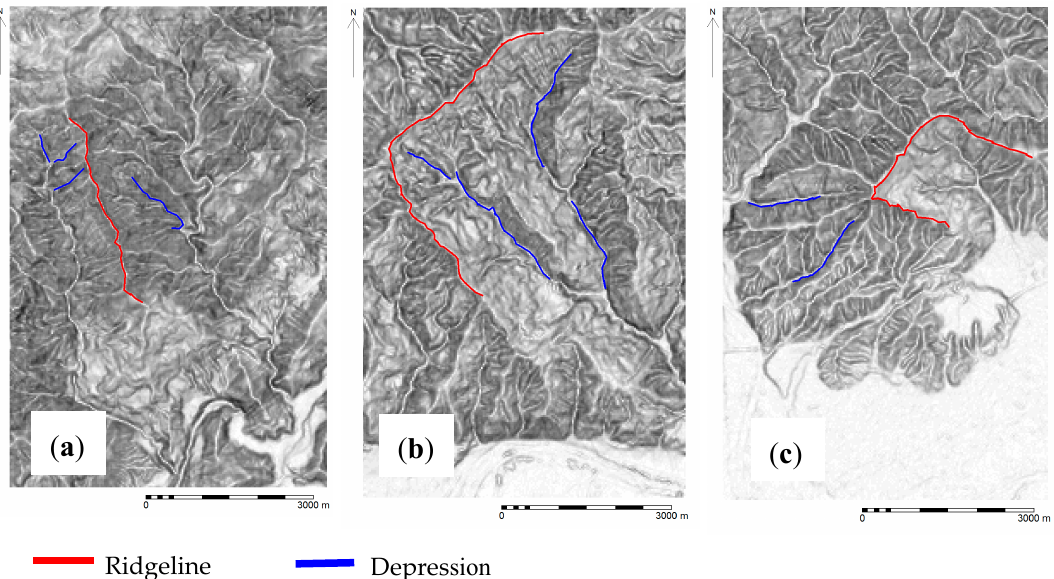
Figure 3. Locations of representative depressions and ridgelines digitized at sites ( a ) Site A, ( b ) Site B, and ( c ) Site C.